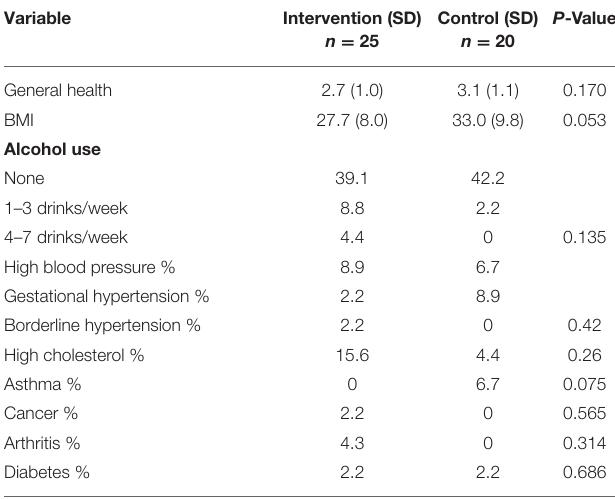
TABLE 4 | Health-related characteristics of participants in a dance-movement program.